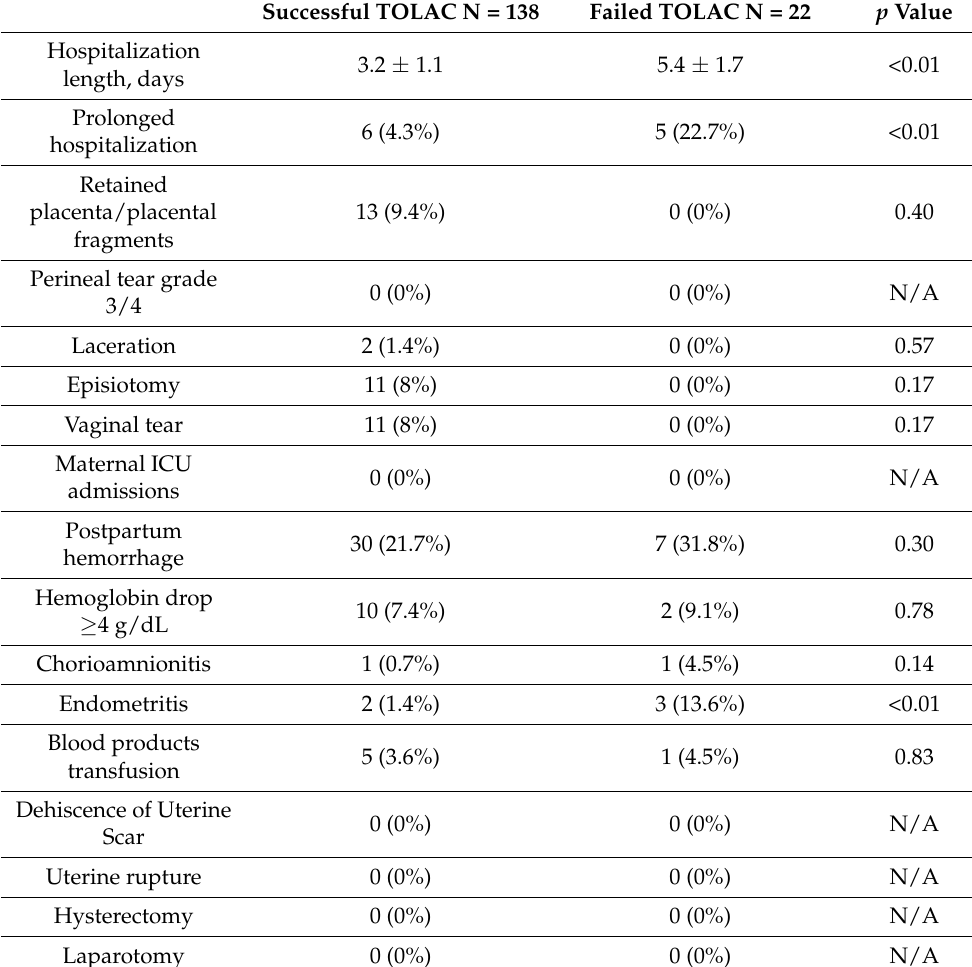
Table 2. Maternal outcomes.